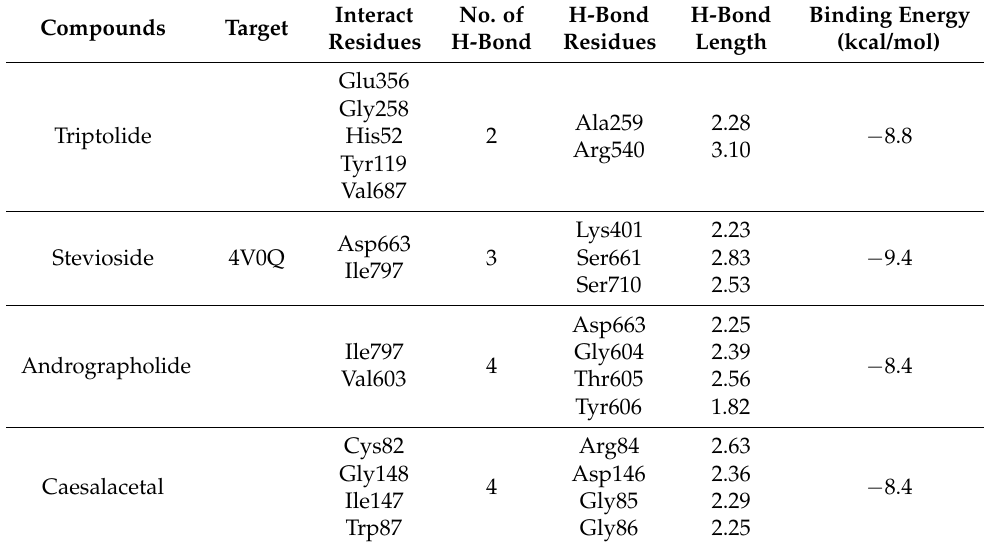
Table 5. The four best results for the docking of natural bioactive ligands with viral proteins target (NS1).